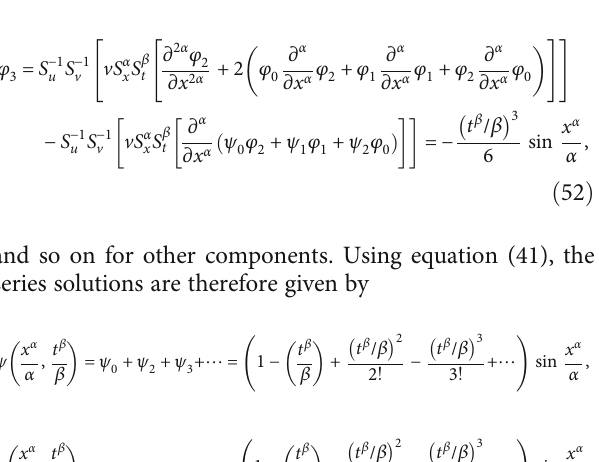
Figure 3: The solutions ψ ð x , t Þ = φ ð x , t Þ for equation (68) when α = β = 1